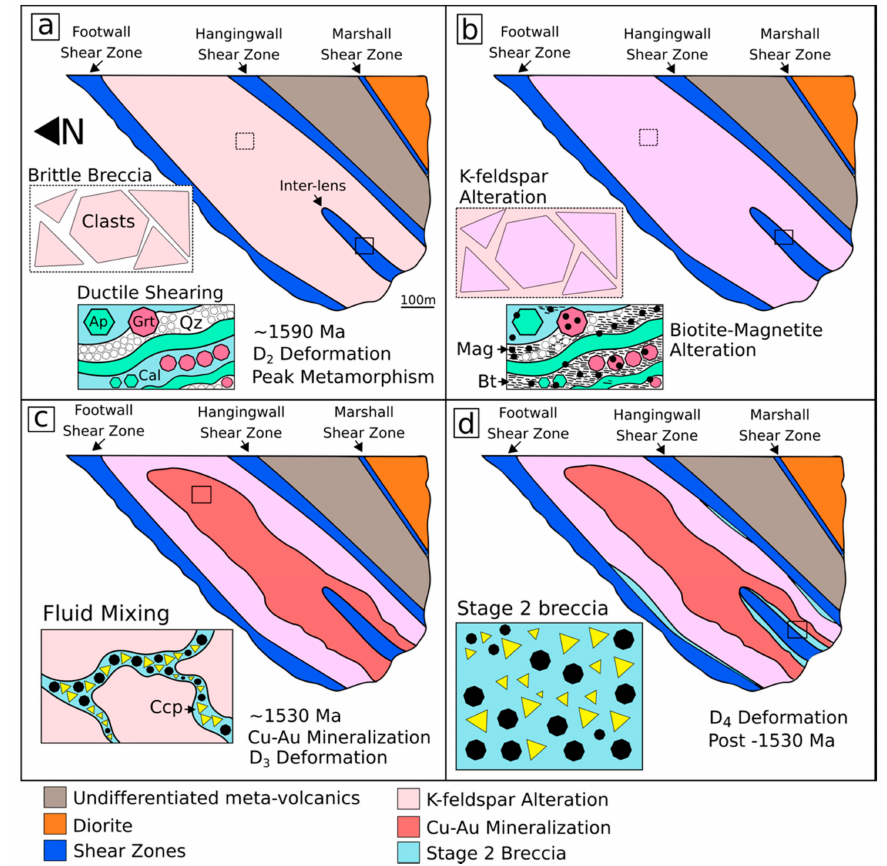
Figure 11. A re-examined formation model for the Ernest Henry IOCG deposit. ( a ) D 2 deformation accompanied by peak metamorphic conditions resulted in brecciation of competent metavolcanic rocks and shearing of the metasedimentary